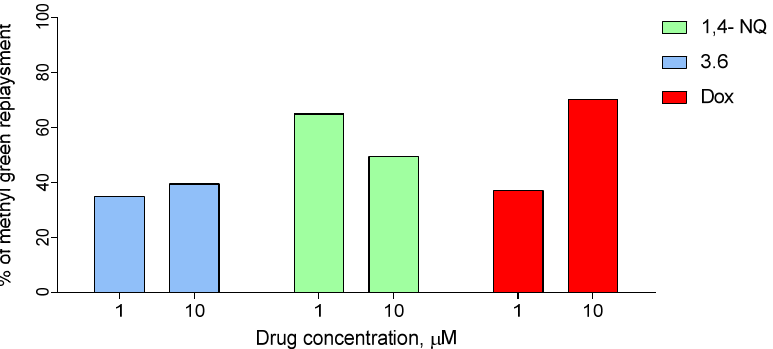
Figure 10. Replacement of methyl green, intercalated to salmon sperm DNA, by the compound 3.6 , 1,4-NQ, and doxorubicin (positive control).